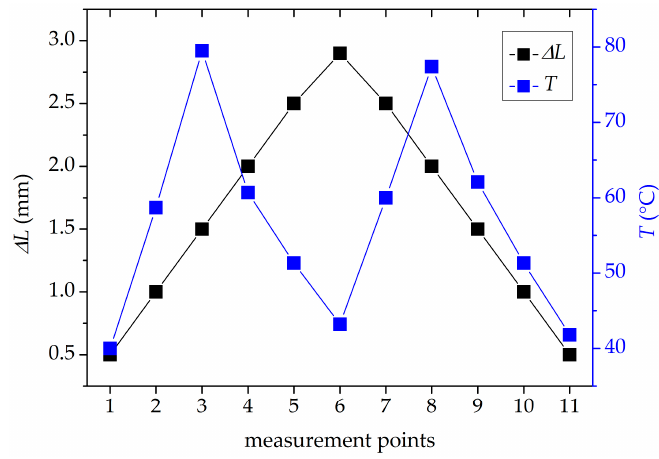
Figure 9. Fiber elongation and temperature values chosen to examine interferometer response to simultaneous changes of the two parameters.